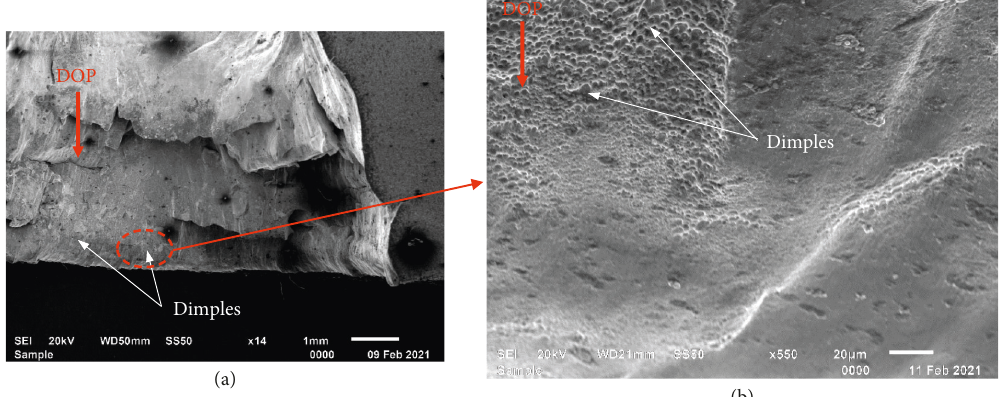
Figure 11: SEM SEI micrographs (a) at the exit point of the penetration hole through an 8mm thick plate and (b) a higher magnification micrograph of the circled area in (a).